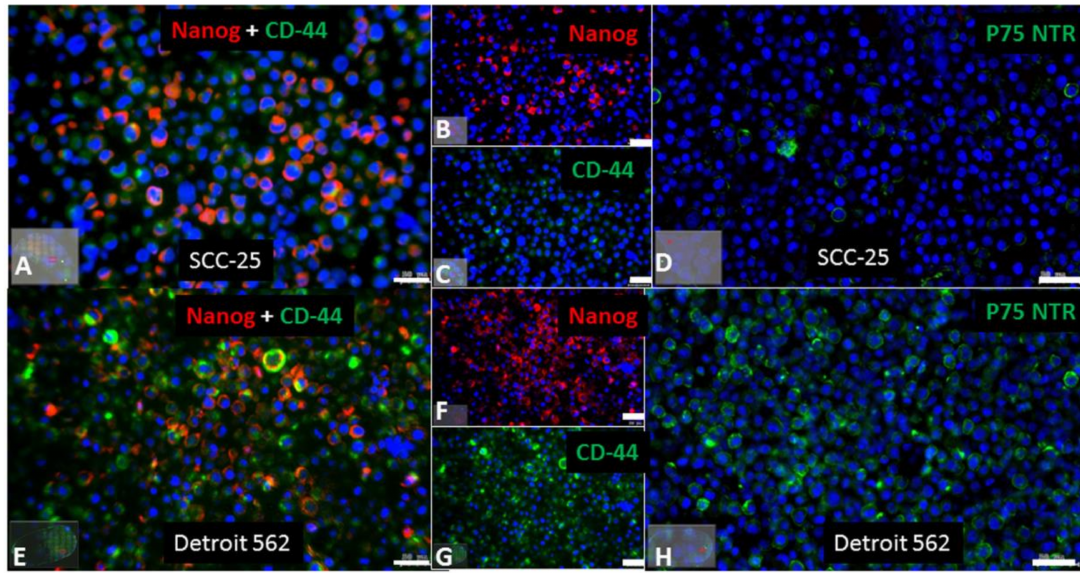
Figure 1. Detection of cancer stem cell markers in SCC-25 and Detroit 562 cells. SCC-25 ( A – D ) and Detroit 562 ( E – H ) cells have been cultured to confluency, collected in pellets, embedded in agarose and in paraffin, sectioned and were subjected to combined indirect immunohistochemical reactions for Nanog (detected in red) and CD-44 (detected in green) ( A – G ) and to single immunohistochemical reaction for p75NTR (detected in green; D , H ). Detroit 562 cells showed more frequent reactions for all cancer stem cell markers. Scale bars: 50 µ